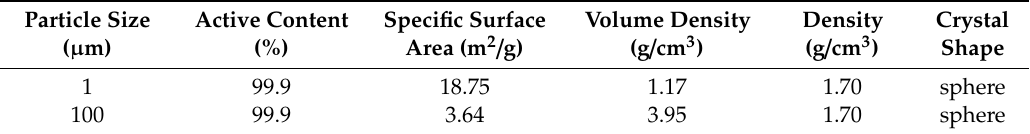
Table 7. Main properties of the tested magnesium particles.